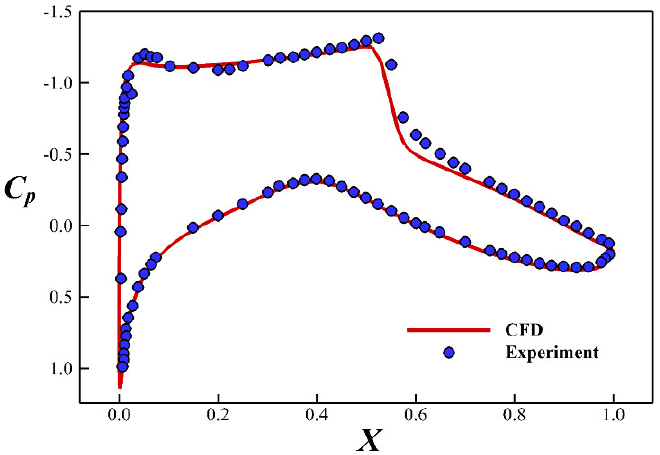
Figure 3. Pressure distribution of CFD simulation and the experiment for RAE2822 baseline.